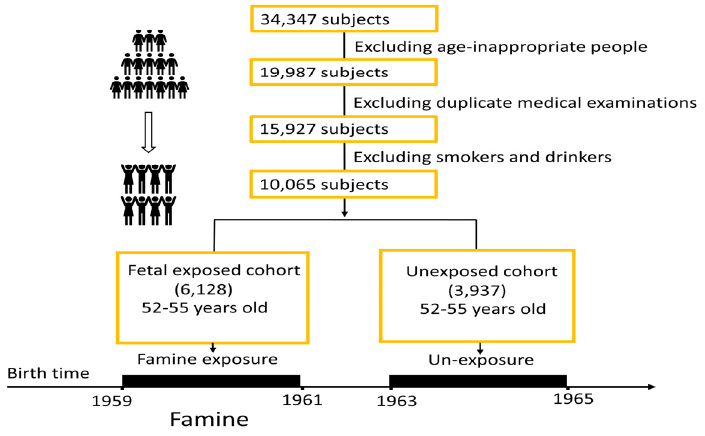
Figure 1. Flowchart of subjects.